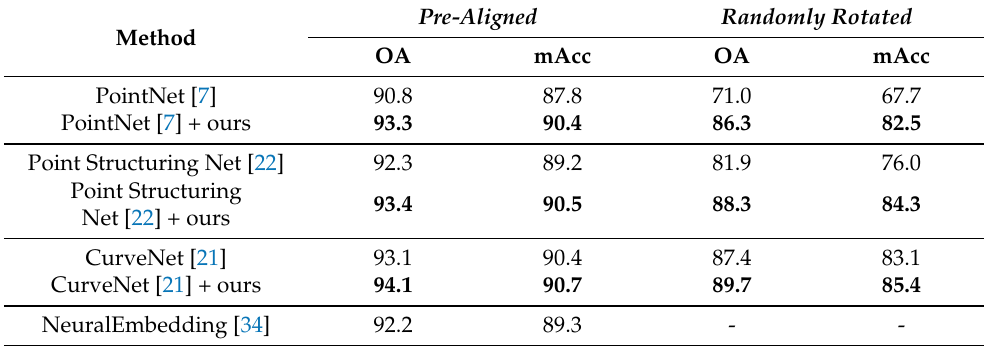
Table 3. Object classification results (%) on the ModelNet dataset